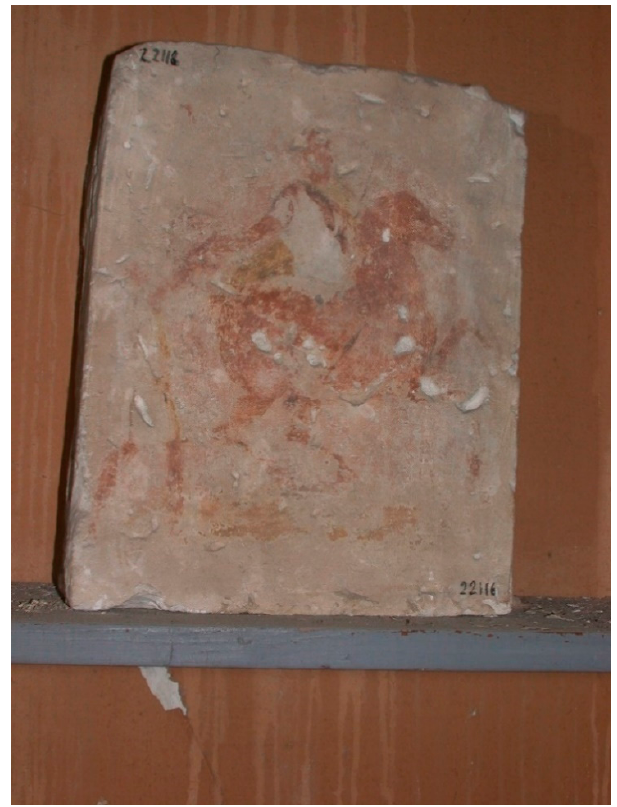
Figure 4. Funerary Stela of a Man on Horseback. © Centre d'Études Alexandrines.